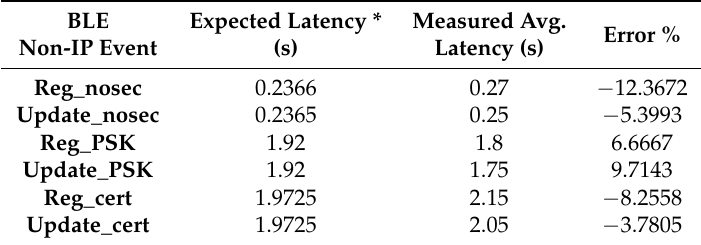
Table 3. Table for BLE latencies for different LwM2M